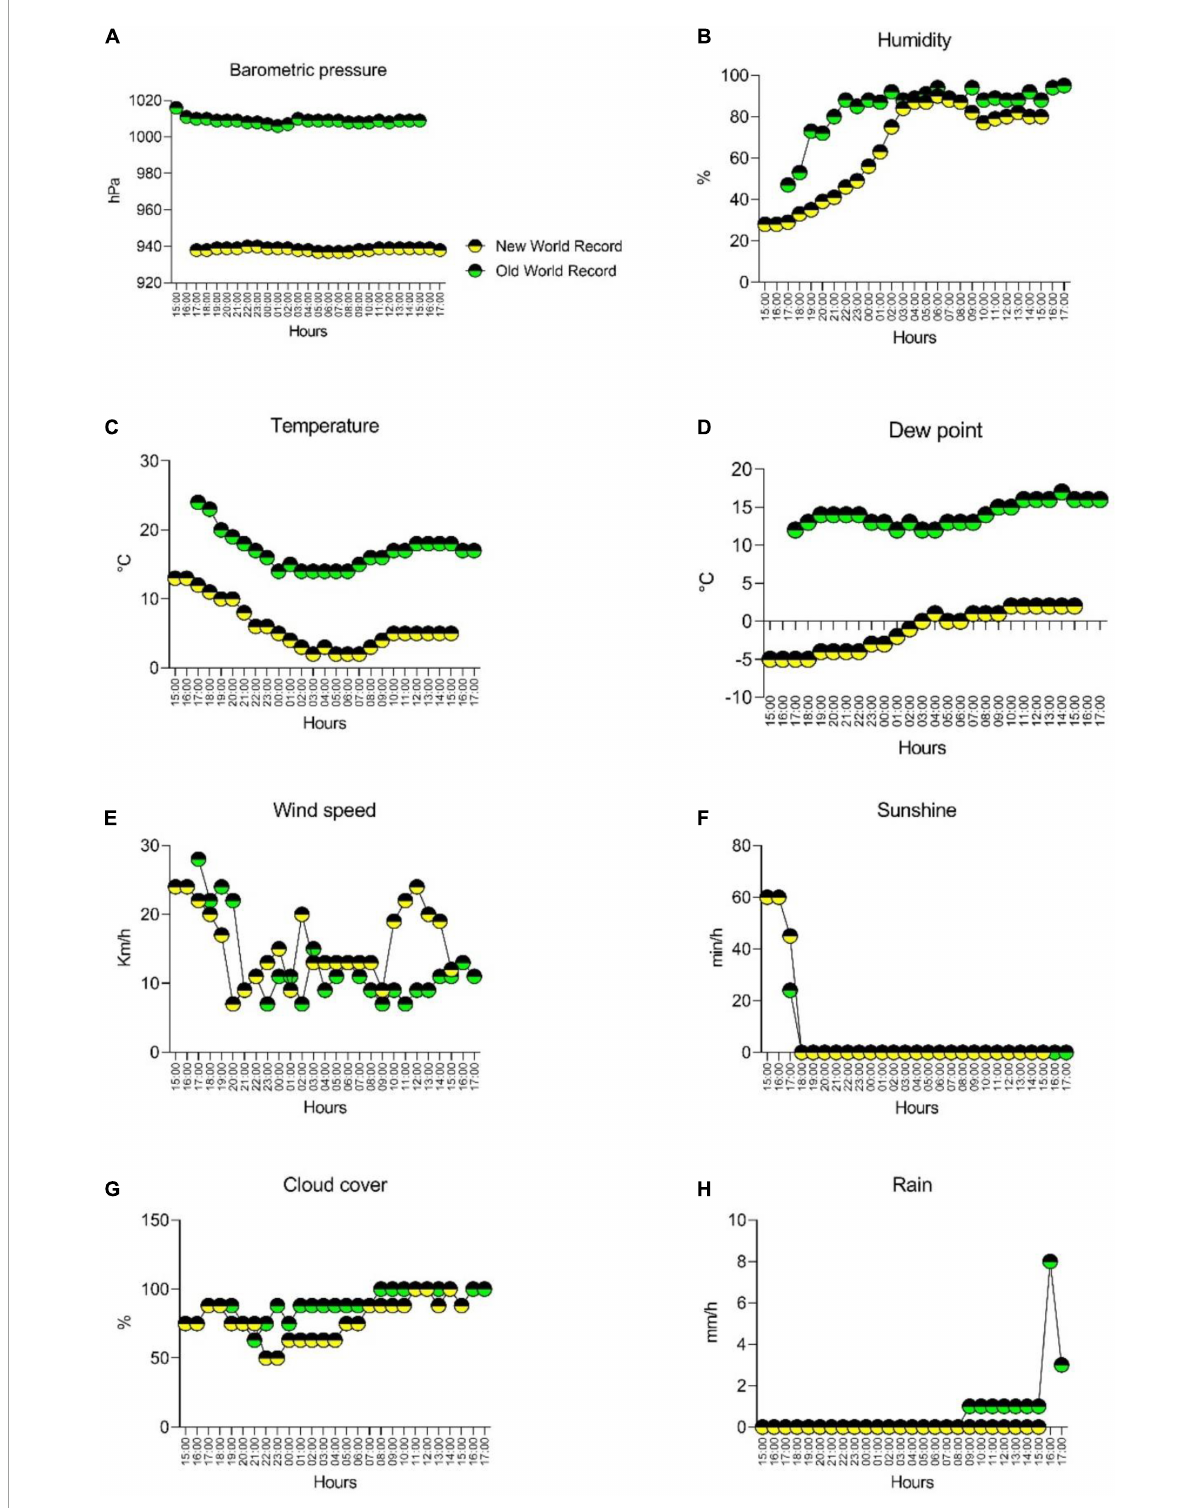
FIGURE1 Hourly weather data for barometric pressure (A) , humidity (B) , temperature (C) , dew point (D) , wind speed (E) , sunshine (F) , cloud cover (G) , and rain (H) for both